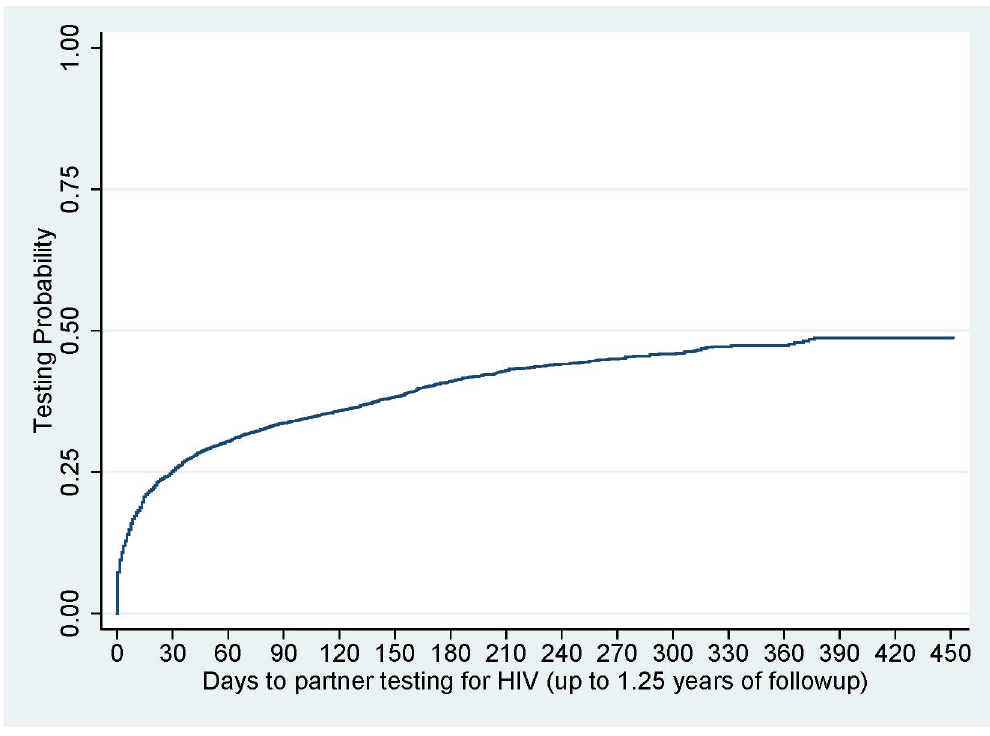
Fig 1. Overall probability of HIV testing among identified sexual